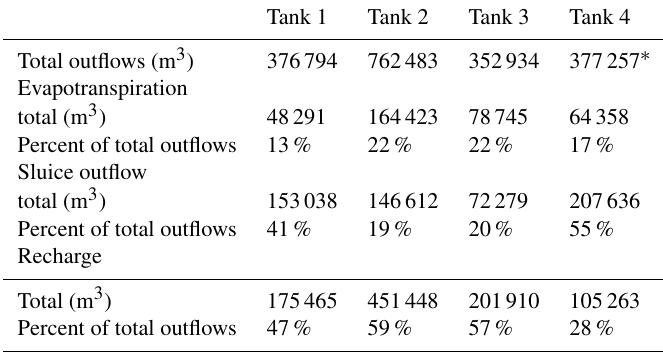
Table 3. Partitioning of tank outflows across the northeast monsoon